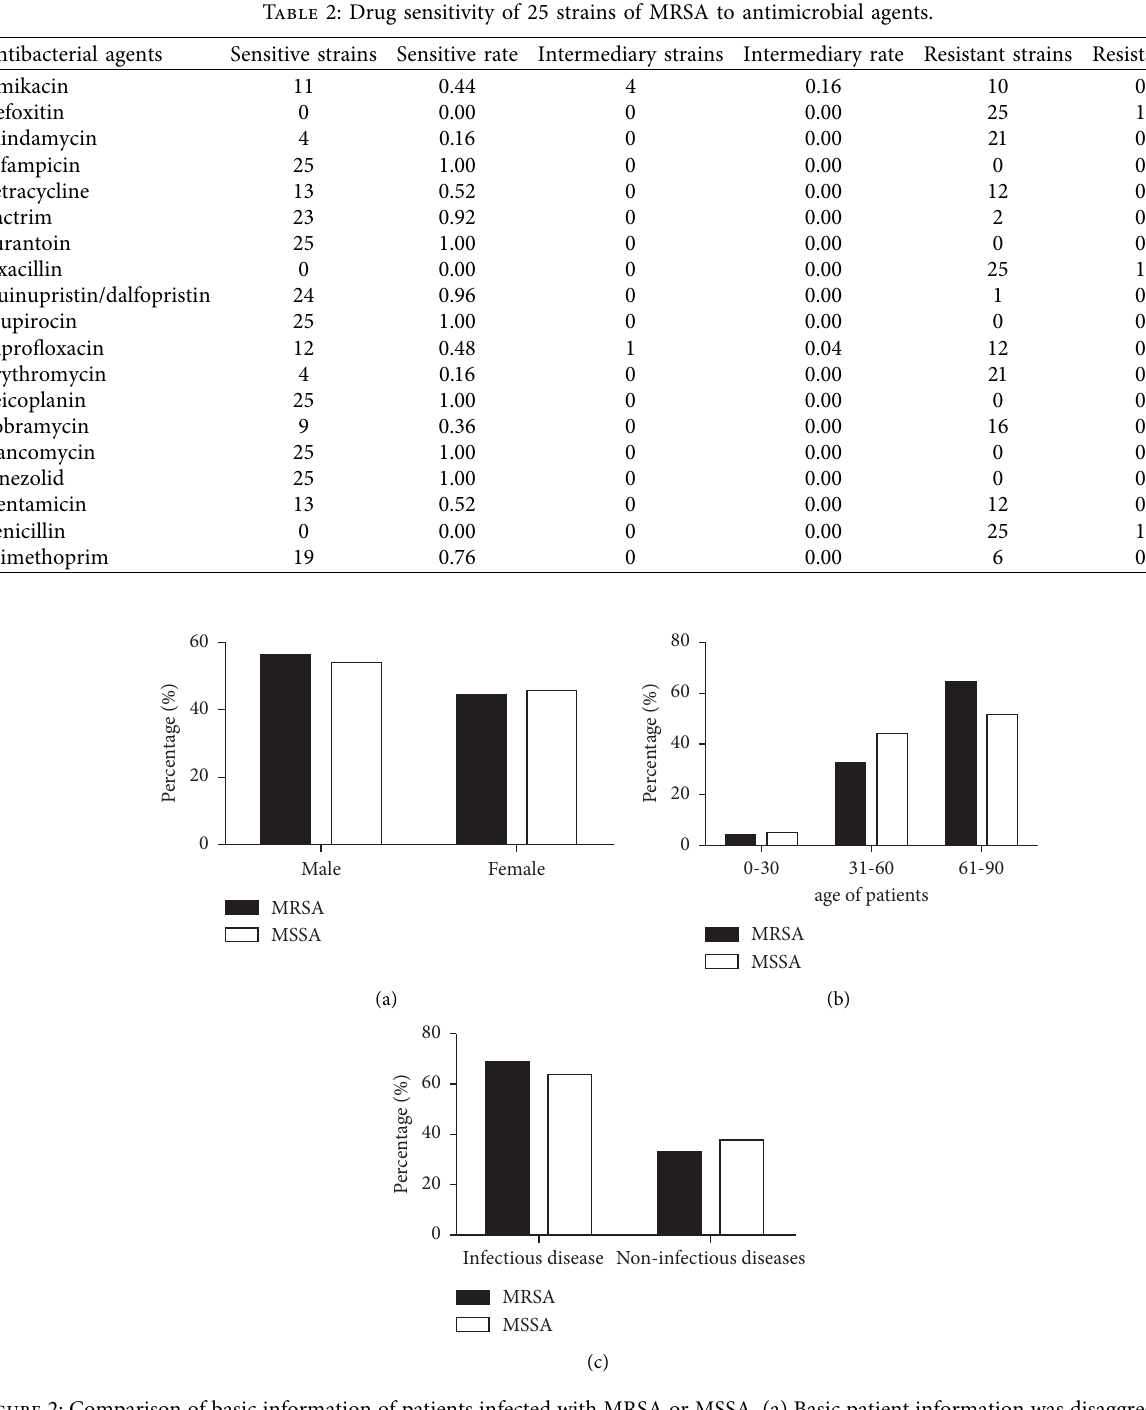
Figure 2: Comparison of basic information of patients infected with MRSA or MSSA. (a) Basic patient information was disaggregated by gender. (b) By age . (c) By whether or not they are infectious